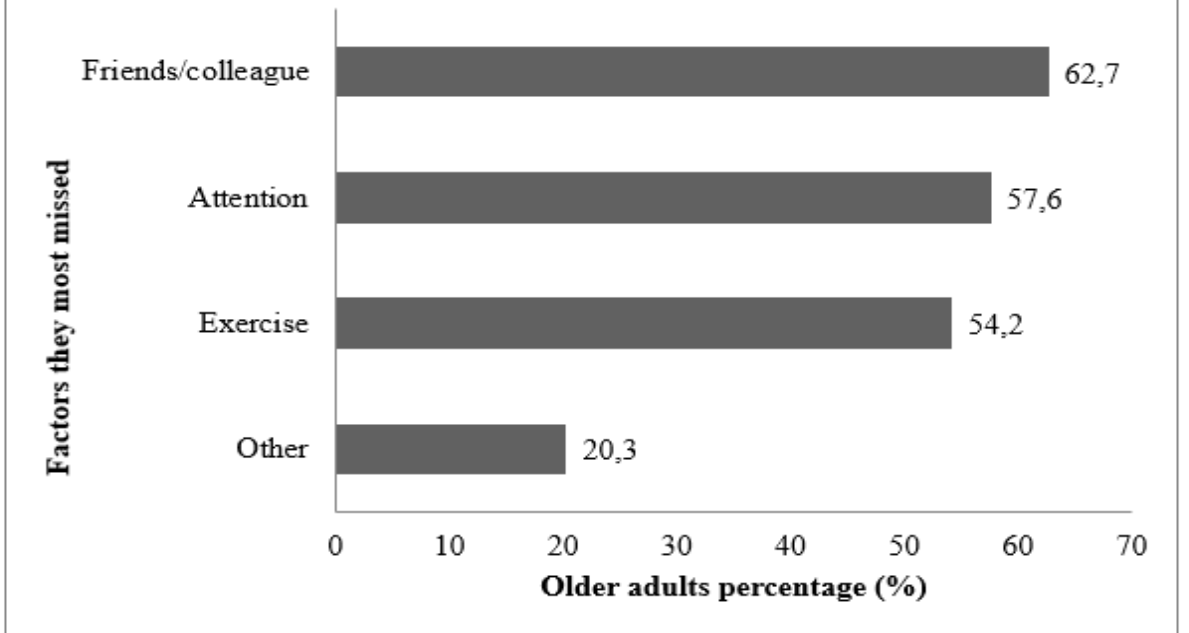
Figure 3 - Factors that older adults missed after abandoning the program.